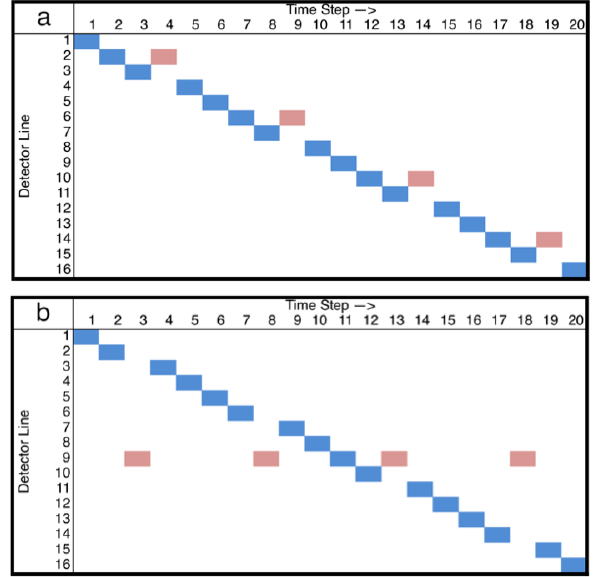
Figure 3. Schematic illustration of alternative strategies for reading check lines (red) by interrupting the systematic readout of the frame area (blue). (a) Check lines “shadow” a subset of the detector lines a short time after systematic readout. (b) A small number of check locations (for clarity only one is shown) are read out